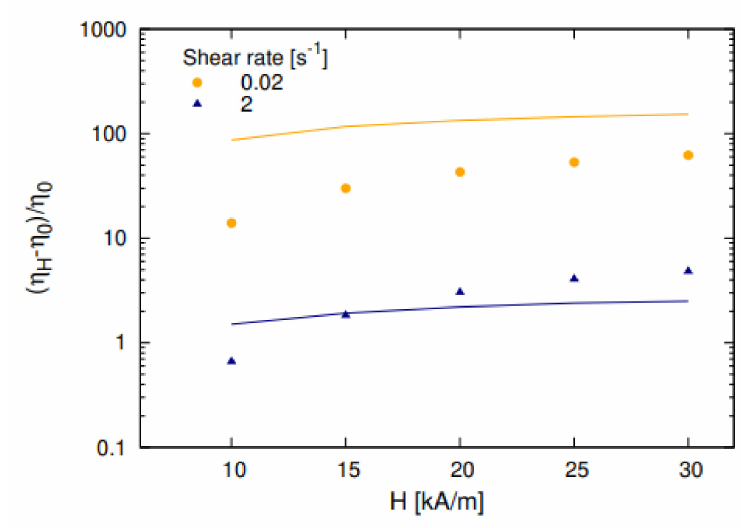
Figure 17. The magnetoviscous e ff ect in a multicore-based ferrofluid was measured and calculated using various shear rates as a function of the applied magnetic field. The solid lines are the results of the calculations performed according to the chain model (hydrodynamic diameter of the particle cluster was assumed to be 90 nm, λ = 2.3) [143].